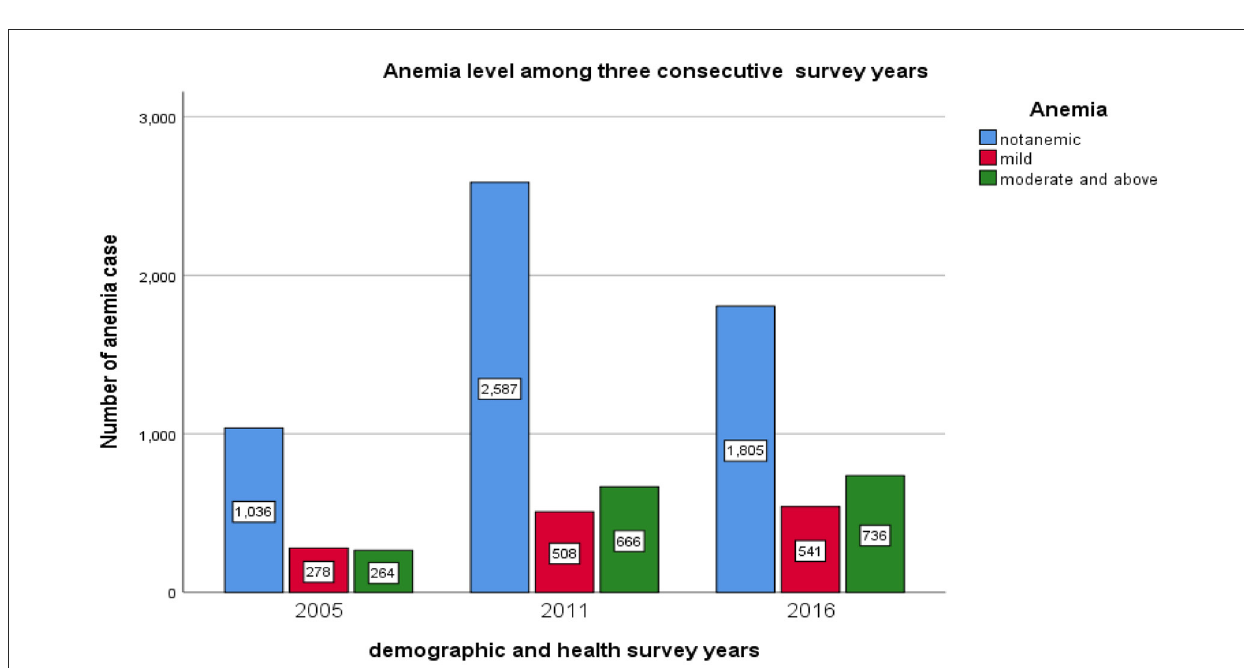
FIGURE3 The bar chart presentation of anemia levels among pregnant women for the three consecutive EDHS data.